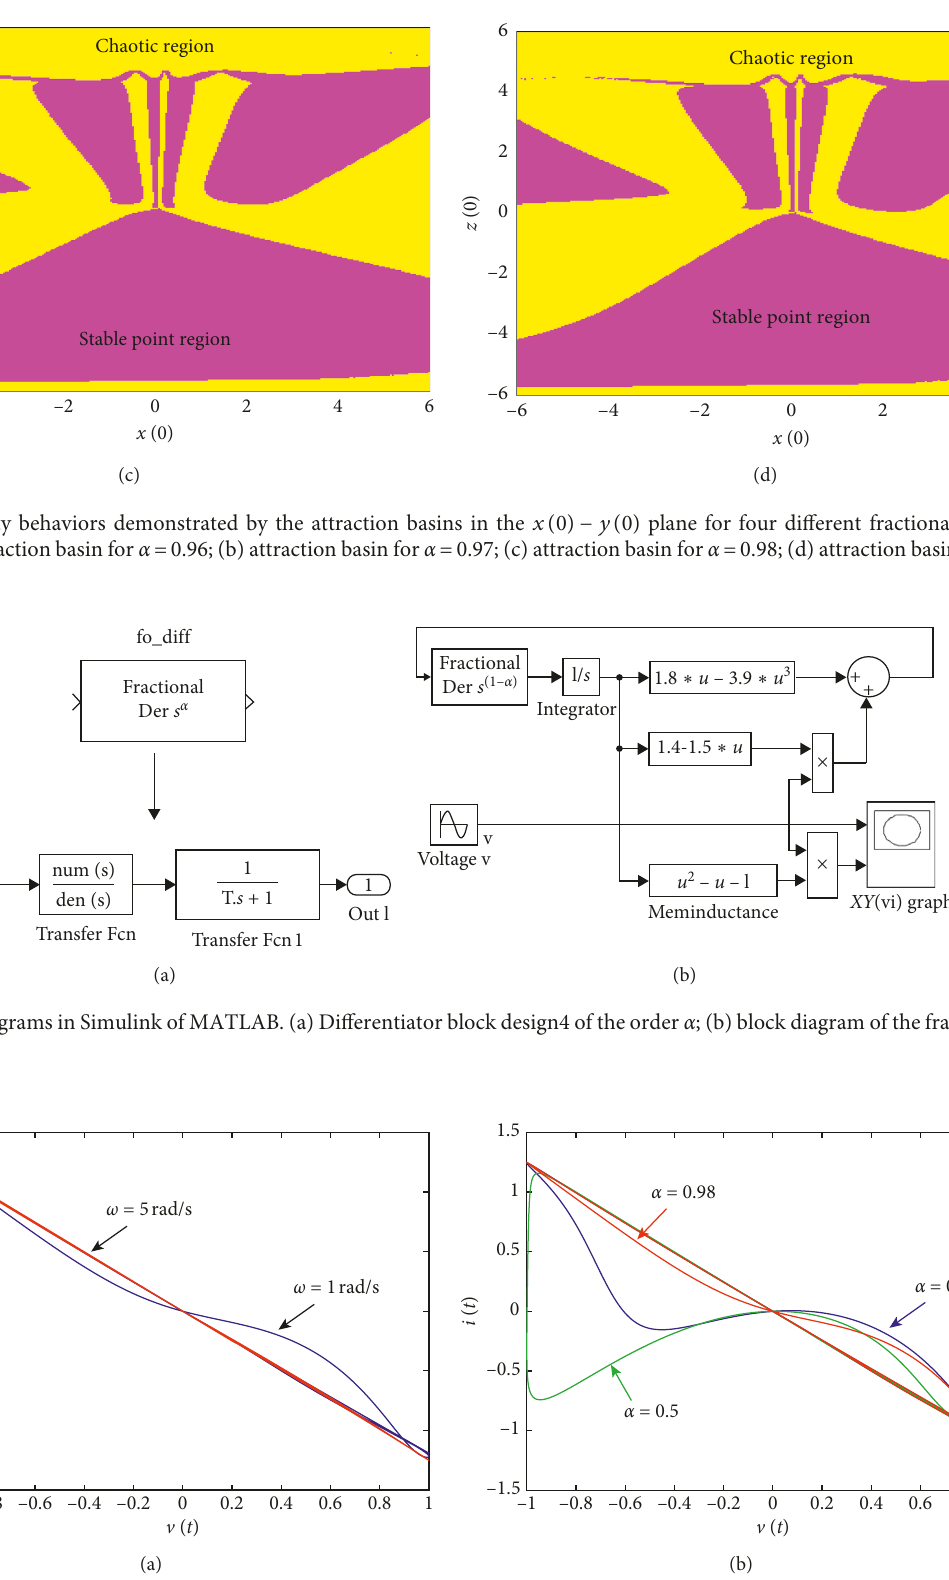
Figure 7: v ( t ) versus i ( t ) of the fractional-order memristor from the scope (XY Graph) in Figure 6(b). (a) The order α � 0.98 with two different frequencies; (b) the frequency ω � 1rad/s with three different fractional